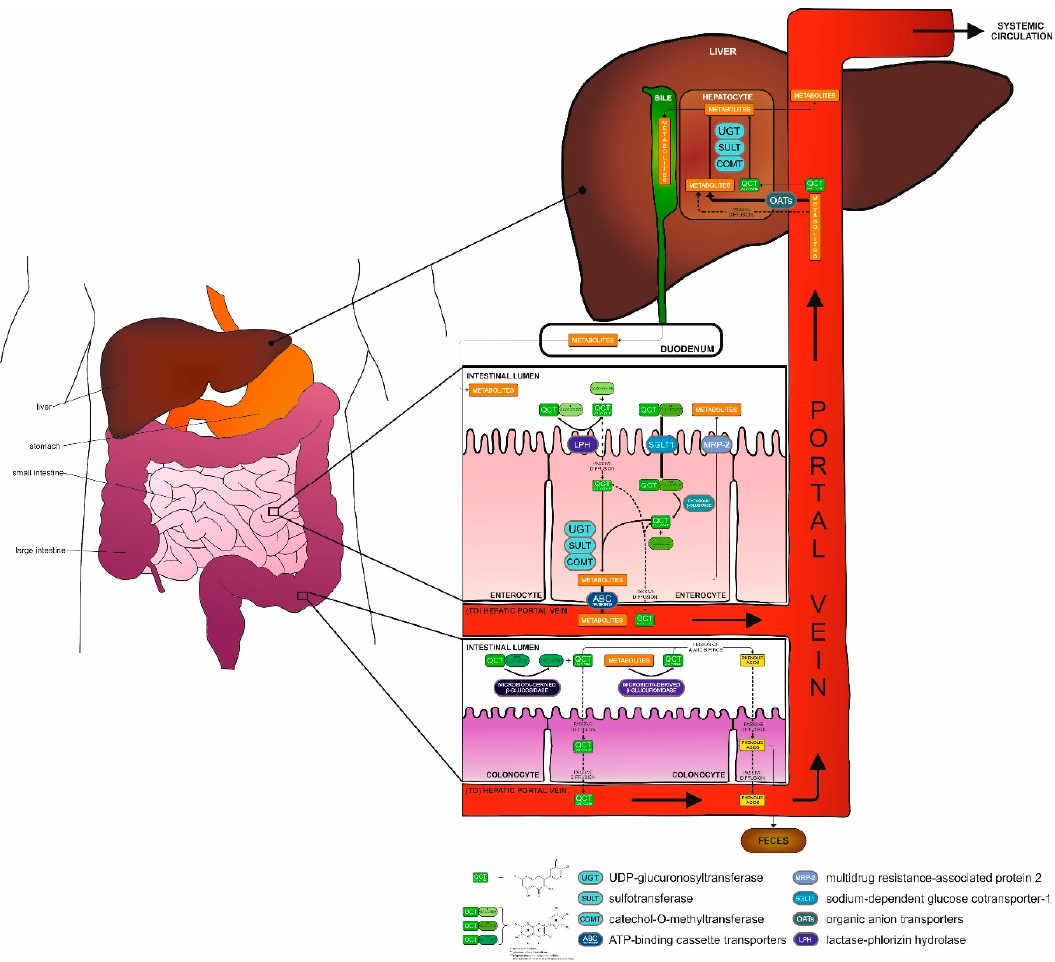
Figure 2. Overview of QCT metabolization in the body. QCT and its monosaccharide* derivatives (including QCT glucoside**) are metabolized in small intestine. After a chain of reactions catalyzed by enzymes UGT, SULT or COMT causing glucoronidation, sulfation or methylation, respectively, QCT metabolites are either transported by ABC transporters to the portal vein and then to liver or re-uptake and transport back to the intestinal lumen by MRP-2, continuing to the large intestine. QCT aglycone as a possible product of QCT glycosides and QCT glucosides is transferred by passive diffusion through enterocytes to hepatic portal vein and consequently to the liver. In the large intestine, mainly QCT oligosaccharides and polysaccharides (QCT glycosides***) are enzymatically deglycosylated to QCT aglycone, which is transported from intestinal lumen to portal vein by passive di ff usion through colonocytes. Degradation of QCT metabolites, which were transported from the small intestine to the large intestine, occurs in the large intestinal lumen, where they are degraded to phenolic acids. In the liver, further metabolization of thus far created QCT metabolites or QCT aglycone occurs by their conjugation (by UGT or SULT) or modification (by COMT). Finally, QCT metabolites are transported from liver to either systemic circulation or back to duodenum (small intestine) via bile, possibly heading to large intestinal final degradation. For more details, see Chapter